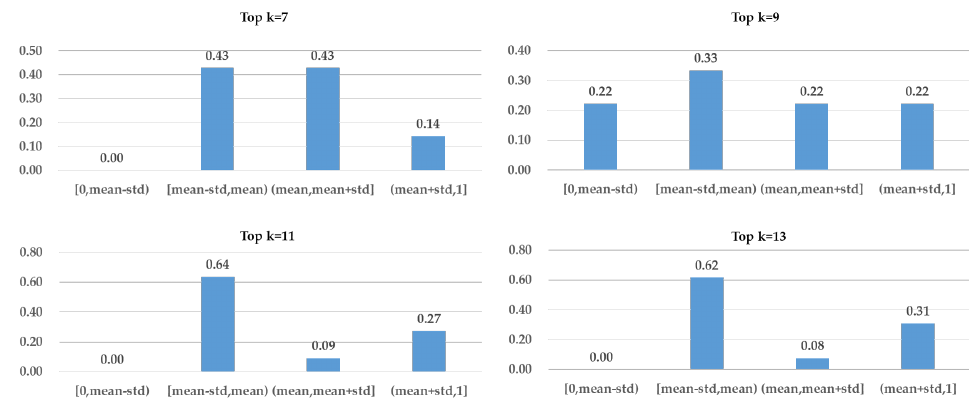
Figure 5. The proportion statistics of the amount in different IoU